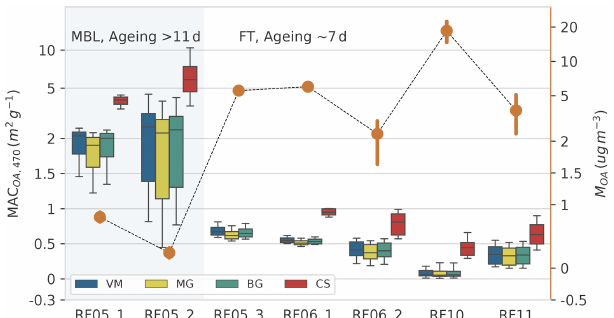
Figure 6. Values of MAC OA , 470 (boxes) derived using different models and the mass concentration of OA, M OA (orange dots, left y axis), for each flight. Error bars represent 1 σ standard deviation. The scale of both x axes is symmetric log. The horizontal lines of box plot represent the median value, the boxes represent the 25th to 75th percentile, and the whiskers represent 1.5 times the interquar- tile range. RF05_1 and RF05_2 were measured in the MBL with plume aged larger than 11d; other flights were measured in the FT with ageing time around 7d. The aerosol/plume age provided by a 2-week forecast using the Weather Research and Aerosol Aware Microphysics (WRF-AAM)